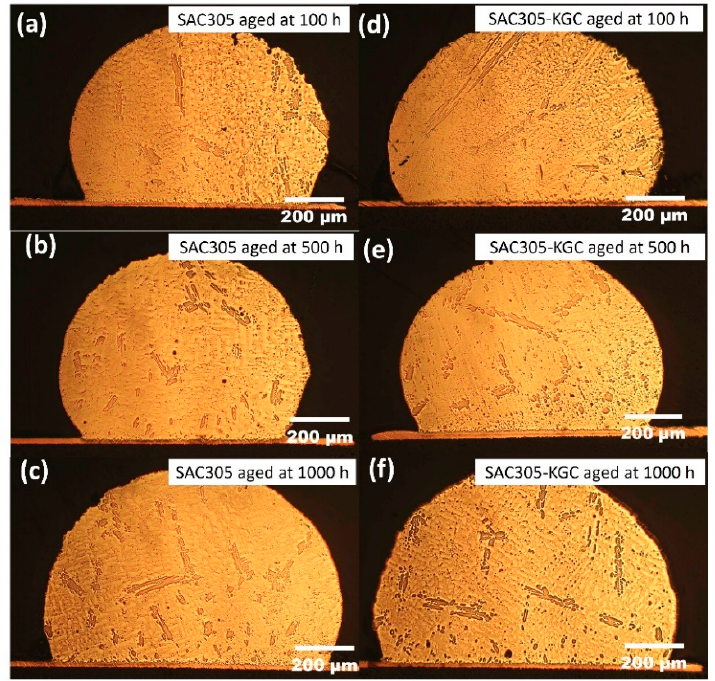
Figure 3. Microstructure formation at the bulk solder after isothermal ageing at 125 °C. Non- reinforced SAC305 solder at ( a ) 100 h, ( b ) 500 h, ( c ) 1000 h and SAC305-KGC composite solder at ( d ) 100 h, ( e ) 500 h, ( f ) 1000 h.